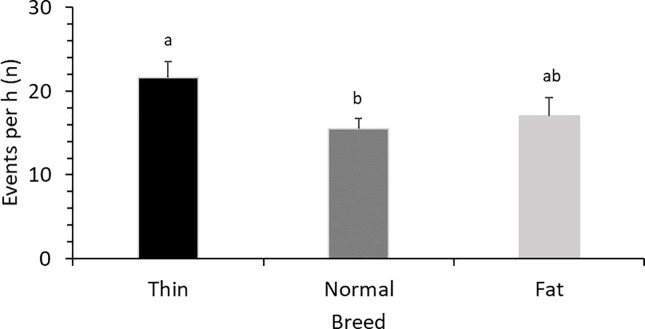
Frequency of communication (LS means ± SE) with piglets while resting for sows that were categorized as either thin, normal or fat with respect to body condition (F 2, 67 = 4.0; P = 0.023).Superscripts (a, b) means significant differences (P<0.05).